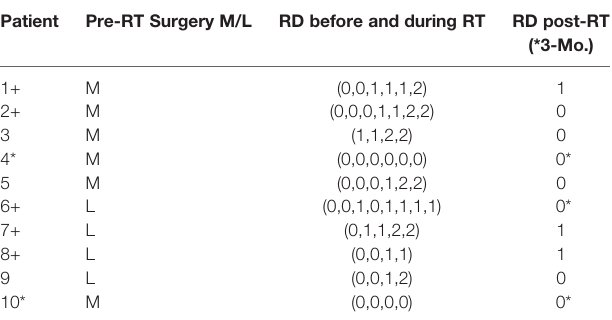
TABLE 3 | The CTCAE RD gradings at each imaging session for each patient is obtained from the clinician. Patient Pre-RT Surgery M/L RD before and during RT RD post-RT